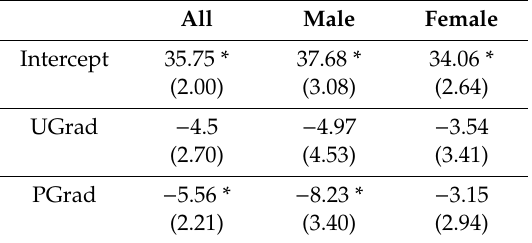
Table 2. Variation in hearing loss with education level at baseline ( n = 99).